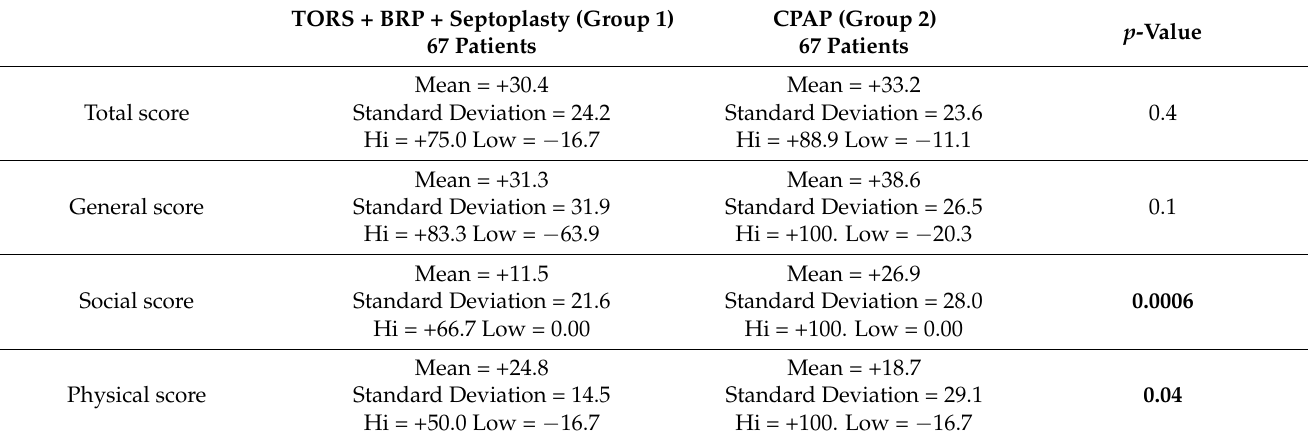
Table 2. Glasgow Benefit Inventory (GBI) results of the two treatments for OSA investigated. Ab- breviations: Continuous positive airway pressure (CPAP); Transoral robotic surgery (TORS); Barbed reposition pharyngoplasty (BRP); Glasgow Benefit Inventory